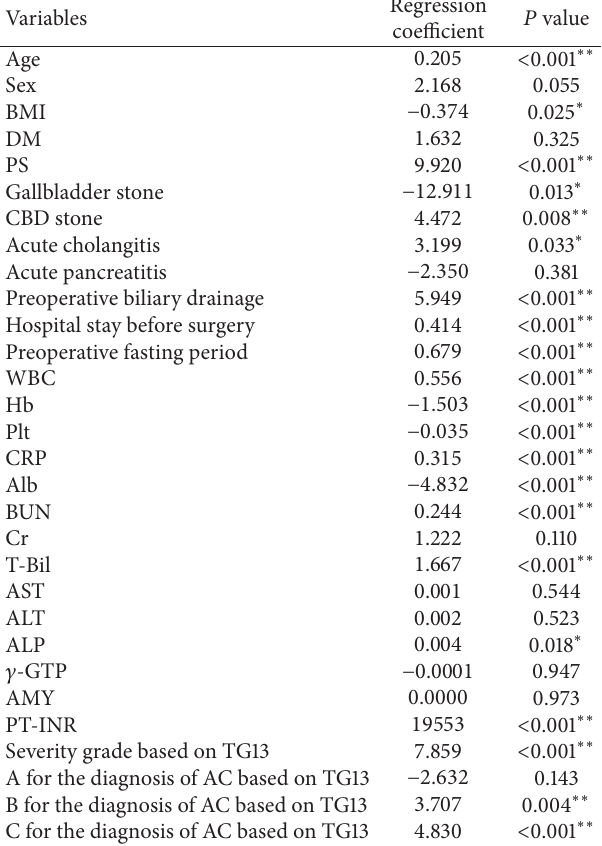
Table4:UnivariateanalysesofthefactorsinfluencingPHSinthe171 patients who had definite, suspected, or unmatched AC